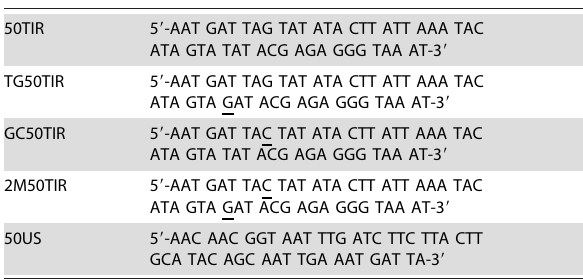
Table 3. Gel shift substrates. a